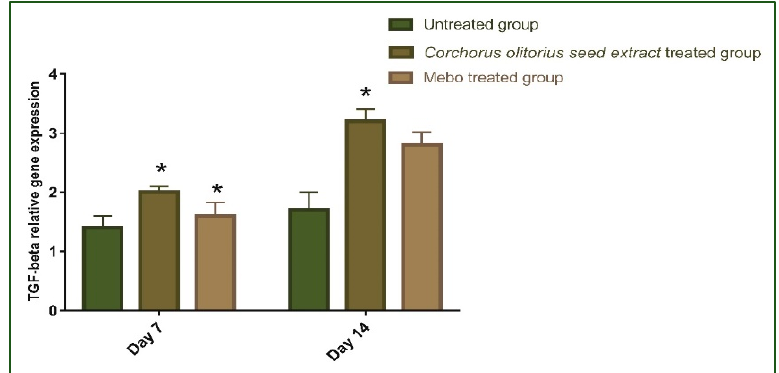
Figure 5. Gene expression in wound tissues for rabbits of different groups via quantitative RT-PCR. It was used to evaluate the gene expression in wound tissues for rabbits of different groups. Data represent fold change relative to the normal control group expression after normalization to glyceraldehyde 3-phosphate dehydrogenase ( GAPDH ). Bars represent mean ±SD. Significant difference between groups is analyzed by a two-way ANOVA test, where: * p ≤ 0.001 compared with those of the untreated group on the respective day.